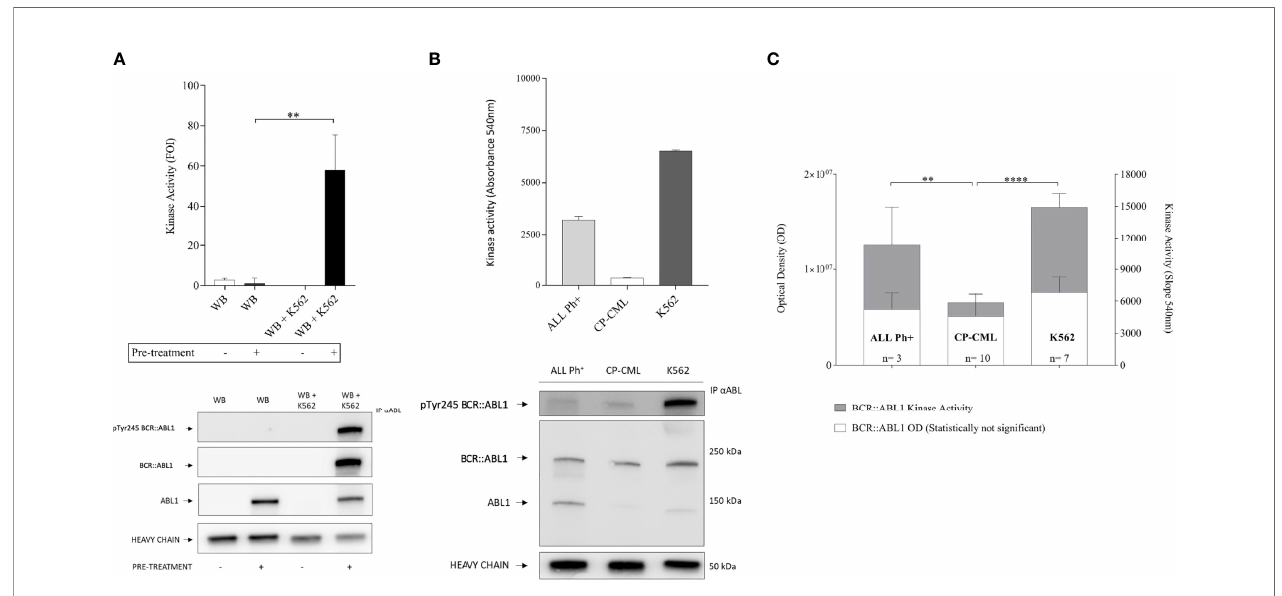
FIGURE 2 | BCR-ABL1 kinase activity measurement in CP-CMLand ALL Ph+patient samples. (A) Immunoprecipitates obtainedfromhealthydonor blood andthe same blood samples mixed with K562 to simulate CMLwere processed with (+) or without (-) R+Lpretreatment protocol and tested for speci fi c kinase activityusing the Abl substrate peptide. Kinase activitygraph (top) andrepresentative Western blot analysis (bottom) underline the preservation of both BCR-ABL1 proteinintegrity and function onlyafter the R +L pre-treatment procedure. (B) Kinase activity assay (top) with BCR-ABL1 protein immunoprecipitated from 500 µg of CP-CML or ALL Ph + primary leukocyte lysate, with K562 cell line as reference. Reduced kinase activity seen in the CP-CML sample compared to a cell line in BC-CML phase (K562) and to the ALL Ph + sample (duplicates). Western blot analysis performed on total and P-Y245 BCR-ABL1 derived from the same immunoprecipitated samples whose activity was measured (bottom). (C) BCR- ABL1 kinase activity from 13 patient samples (including 10 CP-CML and 3 ALL Ph + ) alongside K562 ( n = 7 biological replicates). The values obtained werenormalized by an immunoprecipitated protein amount measured by densitometry analysis (ImageJ software on western blot membrane probed with anti-ABL1-antibody). One-way ANOVA multiple comparison was applied with a p -value signi fi cance threshold of < 0.05 applied. **p = 0.0017; ****p <